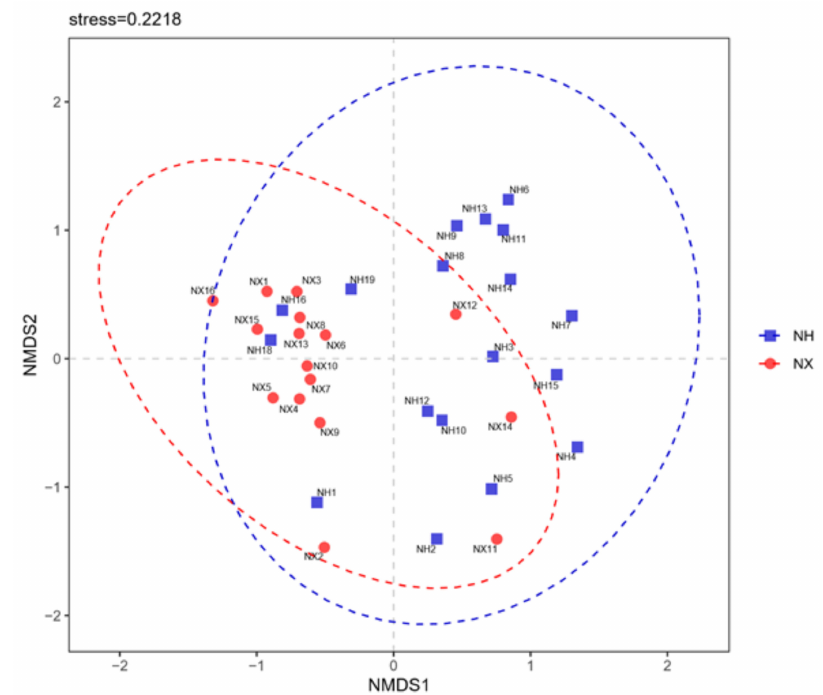
Figure 2. Non-metric multidimensional scaling of colostrum samples from the X and H dairy farms based on bacterial composition. Note: NX ( n = 16) and NH ( n = 18) represent the colostrum samples from dairy farm X and dairy farm